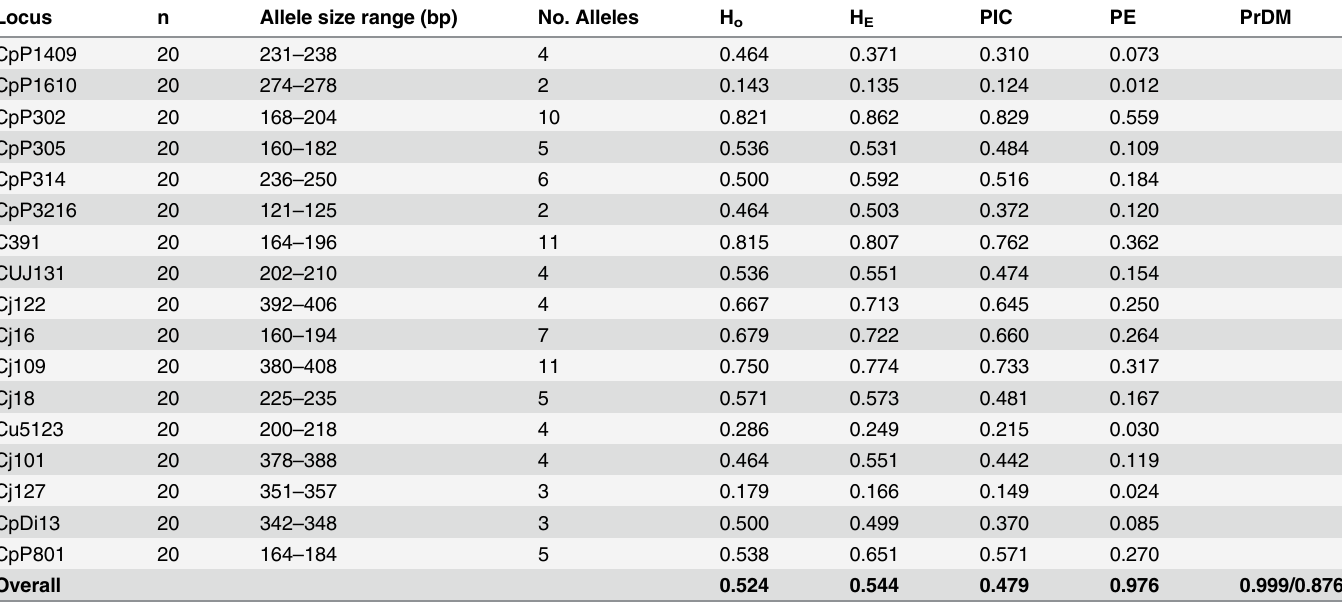
Table 1. Characterization of 17 microsatellite loci in Crocodylus intermedius at the El Frío Biological Station, Venezuela. Locus n Allele size range